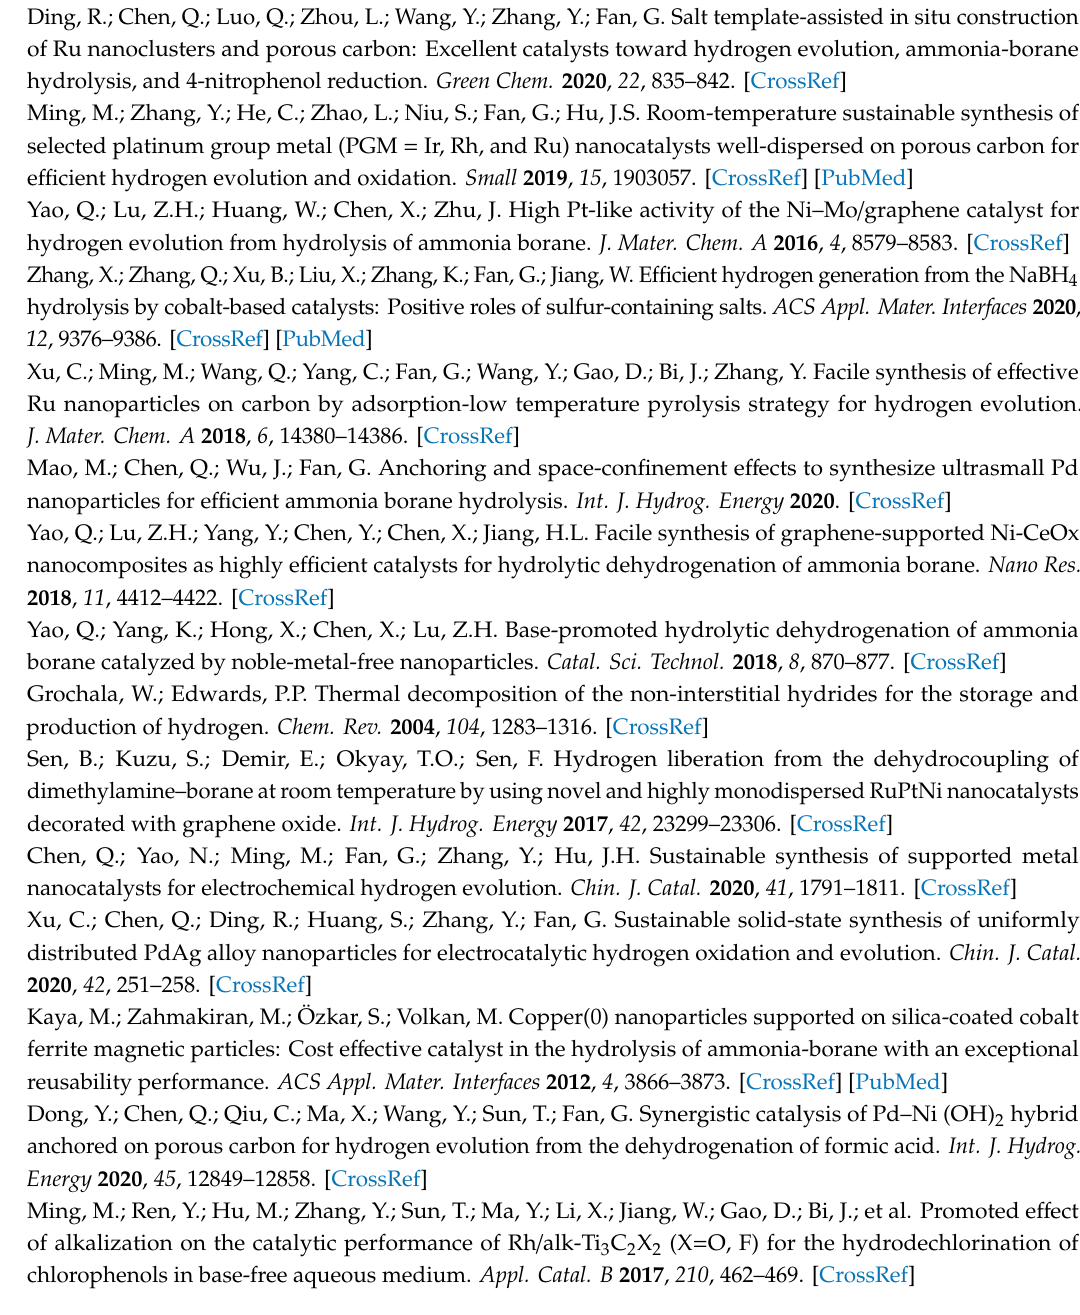
Figure S1: SEM images and mapping images of Pd /